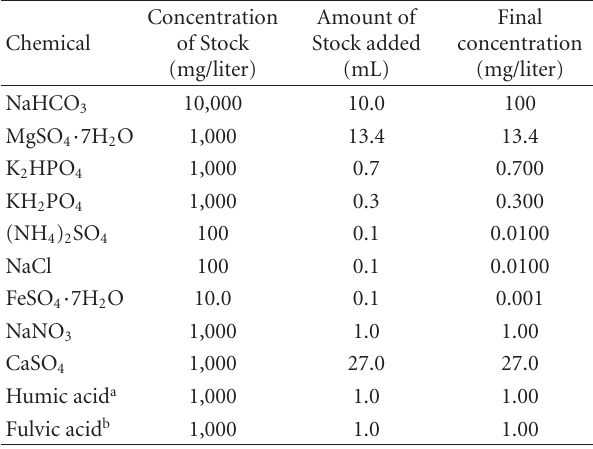
Table 1: Preparation of formulated tap water.